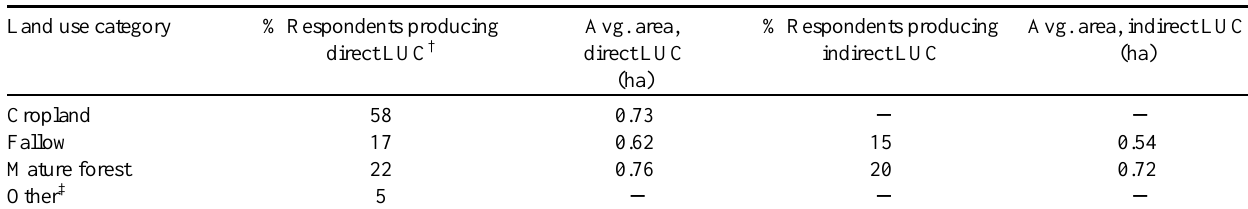
Table 4 . Distribution of different types of direct and indirect land use changes occurring due to jatropha expansion in Chinsali and Mungwi Districts (n =